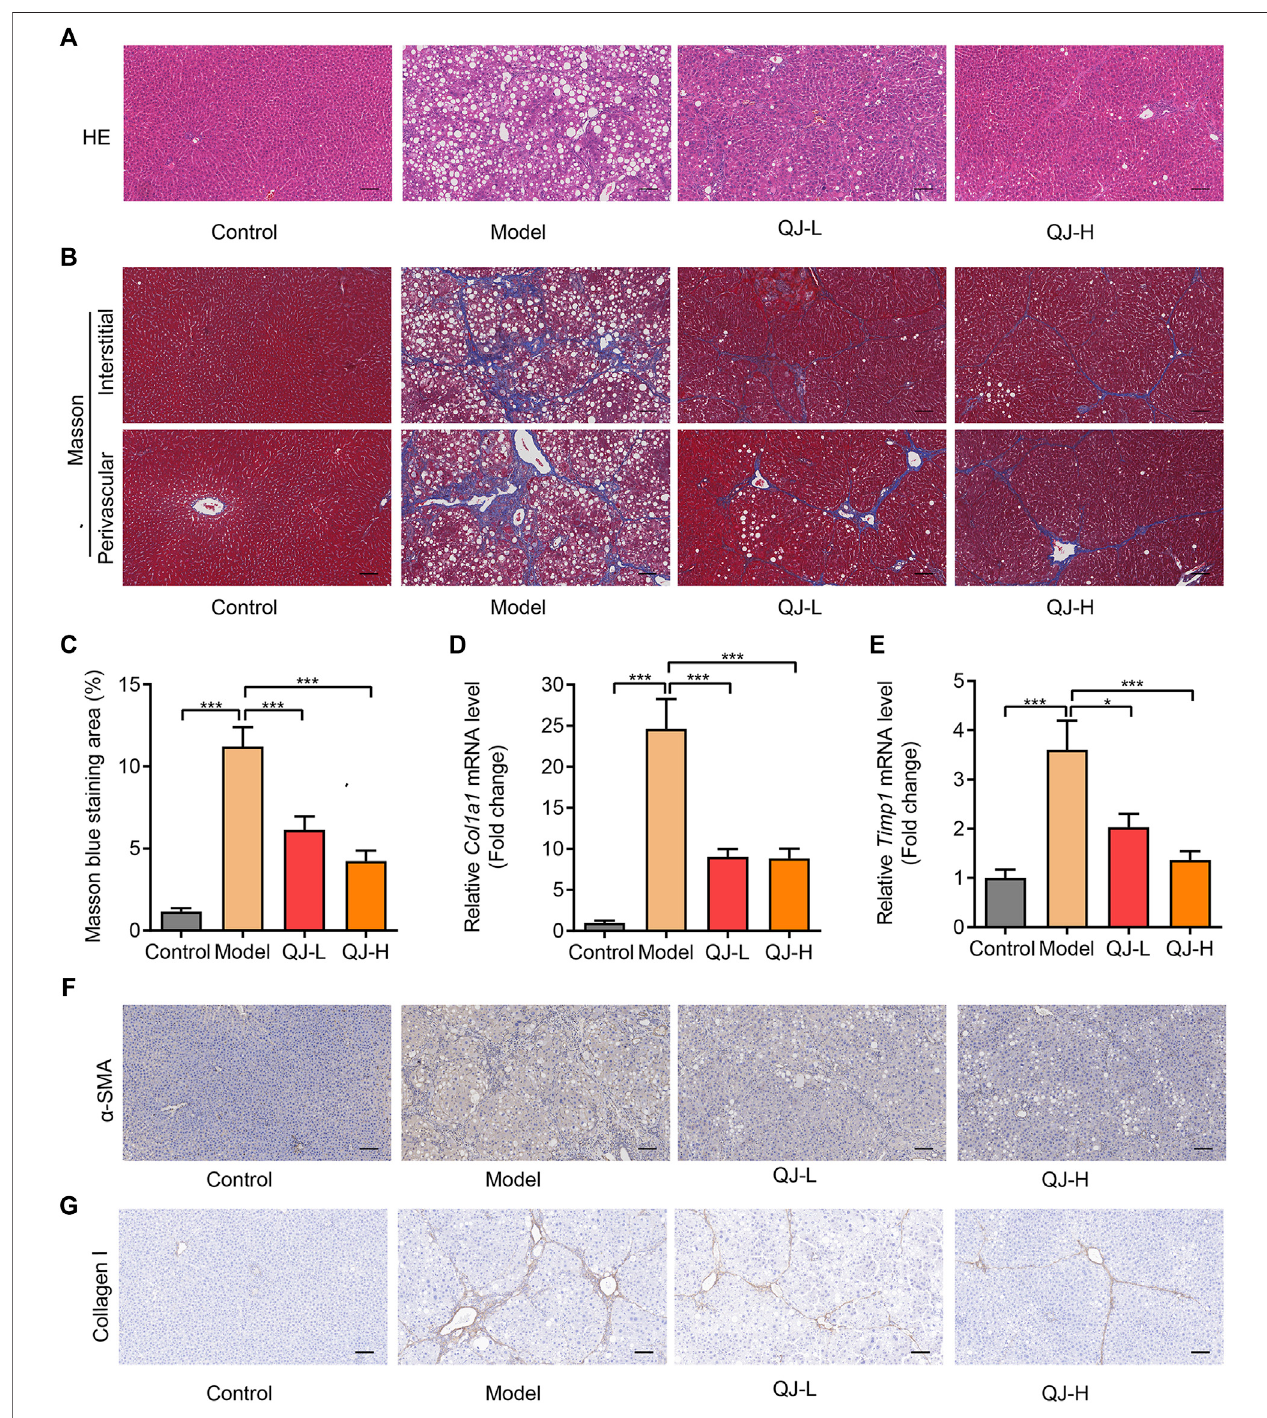
FIGURE3| QijiaRougandecoctionprotectstheratliverfromCCl 4 -inducedinjury. (A) Hematoxylin andeosin(H&E, scalebar =100 µm)stainingwasperformedto detect liver structure in rats; (B) Masson ’ s staining(scale bar = 100 µm) wasperformed todetect liver fi brosis in rats; (C) Quanti fi cation of liver fi brosis infour groups ( n = 8 – 10); (D,E) qRT-PCR was used to analyze Col1a1 and Timp1 mRNA levels in rats ( n = 6 – 12); (F,G) Immunohistochemical (IHC) staining was performed to detect the level of α -SMA and collagen I in the rat liver. * p < 0.05 and *** p < 0.001.